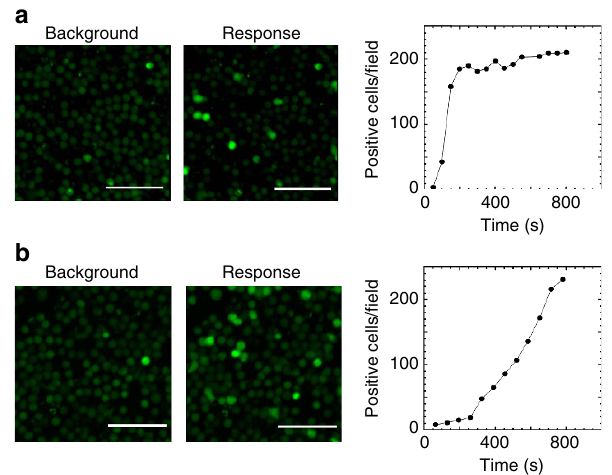
Figure 5 | Kinetics of calcium response of CMV-specific CD8 þ T cells. CMV-specific CD8 þ T cells from a healthy donor ( a ) and a patient after haploidentical stem cell transplantation ( b ) revealed different kinetics of Ca 2 þ signalling on antigen stimulation. CD8 þ T cells were purified from PBMC by negative magnetic sorting and purified CD8 Tcells were labelled with Fluo-4 and immobilized on a glass surface as described in ‘Methods’ section. The T cells from healthy donor were stimulated by CMV-derived peptide NLVPMATV at 10 (cid:2) 4 M while the T cells from the patient were triggered with ProMix CMV peptide pool at 9 (cid:3) 10 (cid:2) 5 M. The images of responding cells are taken at 720s after the stimulation. The data shown are representative of 5 ( a ) and 2 ( b ) independent experiments and are based on the analysis of 4,600 and 4,200 T cells, correspondingly. Scale bars, 50 m